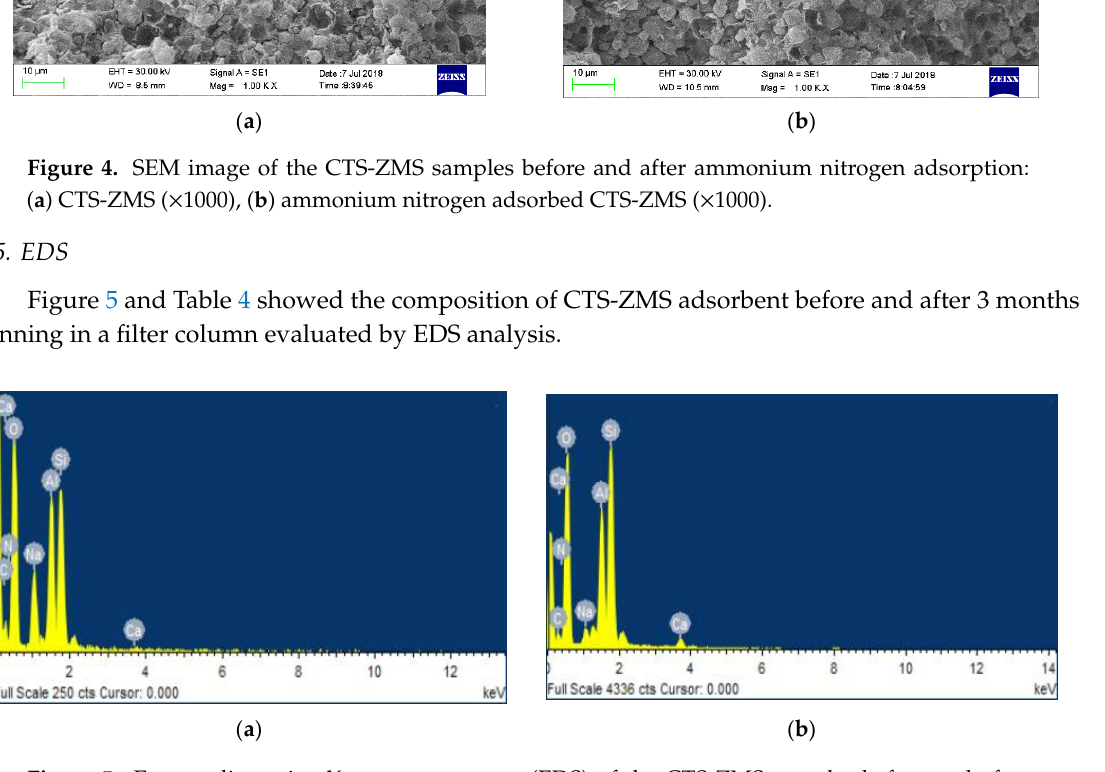
Table 4. Element percentage of CTS-ZMS before and after ammonium nitrogen adsorption in fixed- bed column.